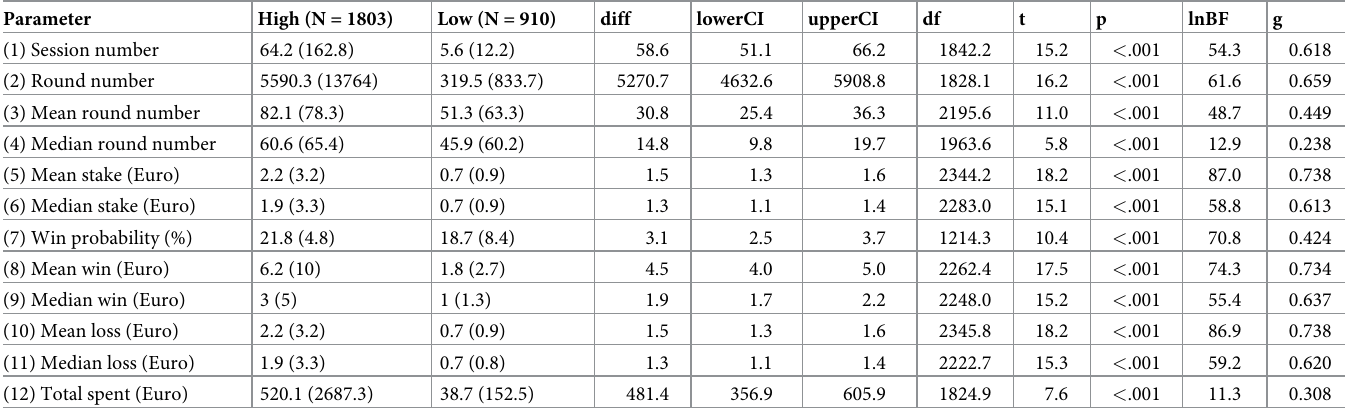
Note: Parameter = behavioral indicators compared between the two groups. See the text for an explanation for each parameter. High, Low = means of parameters for the high- and low-involvement groups, with standard deviations in parentheses. diff = difference between the high-involvement group and the low-involvement group. lowerCI, upperCI = lower and upper boundary of 95% confidence intervals of the difference. df, t, p = degrees of freedom, t value and p value from the Welch’s t-tests. P values were corrected for multiple comparisons using the Holm-Bonferroni method. lnBF = the natural logarithm of Bayes factors. g = Hedges’s average g. amount (in euro), in the rounds where players lost, and (12) the total amount of money spent per player (in euro; a positive value indicates that they overall lost money).